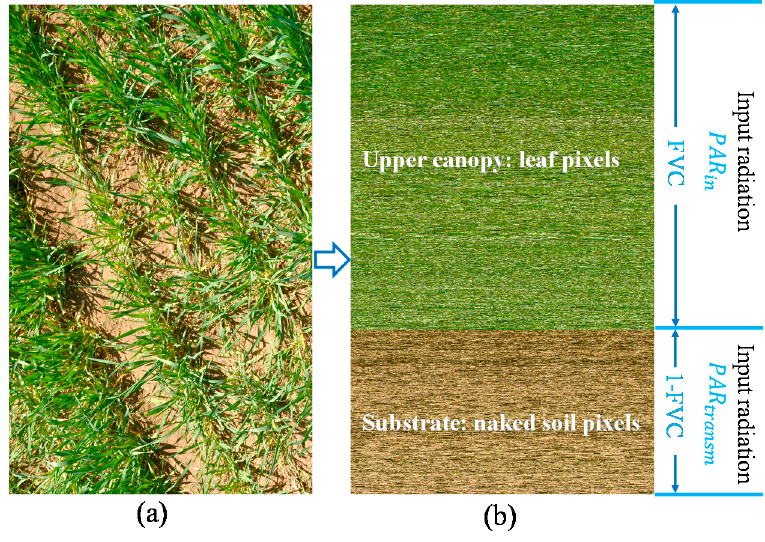
Figure 3. A physical representation of a non-linear spectral mixture model to simplify the dual-source vegetation–soil lay approach. ( a ) The vertical digital photo of a wheat canopy; ( b ) the re-ordered image of ( a ), in which the leaf and soil pixels are placed side by side in the form of a mosaic. For the soil substrate, its input radiation is attenuated by the leaves of the upper canopy. FVC is the fraction of vegetation cover, (cid:1842)(cid:1827)(cid:1844) (cid:3036)(cid:3041) and (cid:1842)(cid:1827)(cid:1844) (cid:3047)(cid:3045)(cid:3028)(cid:3041)(cid:3046)(cid:3040) are the incident and transmitted photosynthetically active radiation,